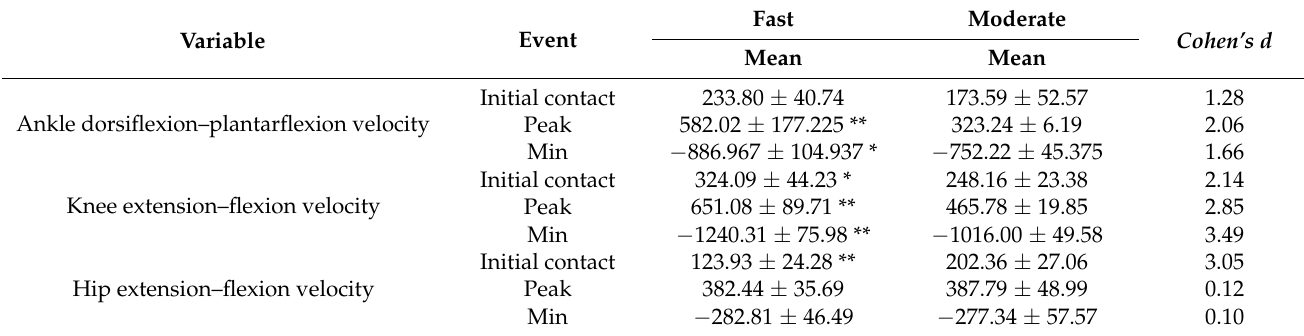
Figure 3. The curves of hip, knee and ankle angular velocities across time. Table 2. The hip, knee and ankle angular velocities (°/s) in each event.